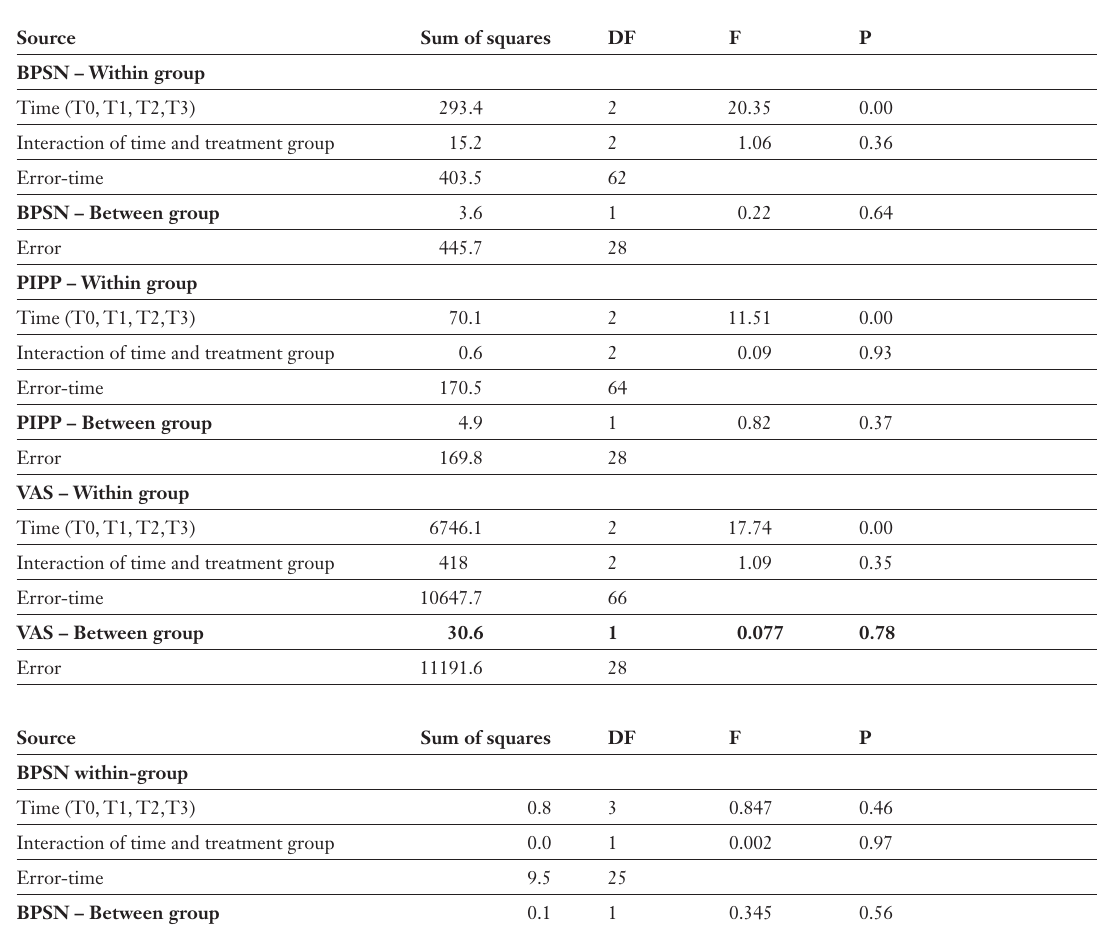
Table 3a Mean of total physio- logical pain scores only of the BPSN.